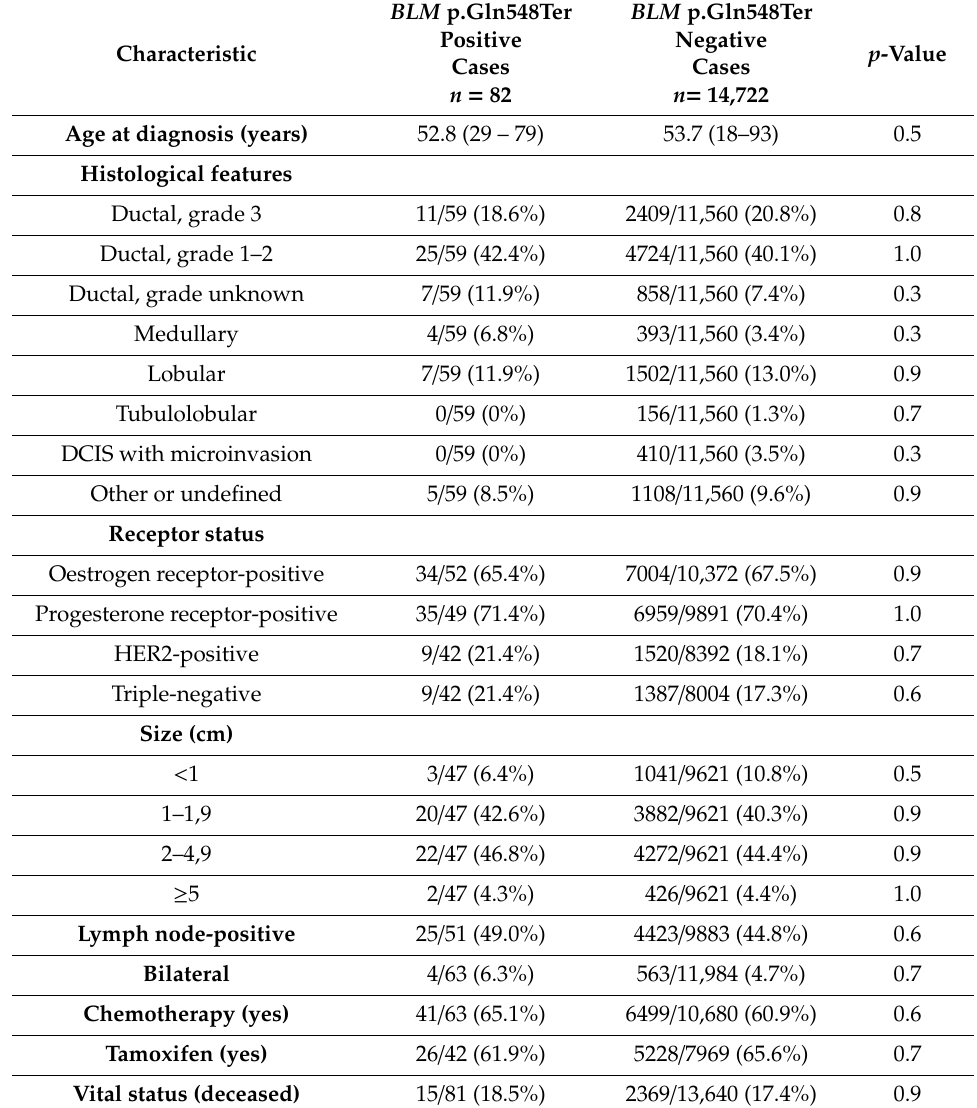
Table 2. Clinical characteristics of breast cancers in carriers of the BLM p.Gln548Ter mutation and